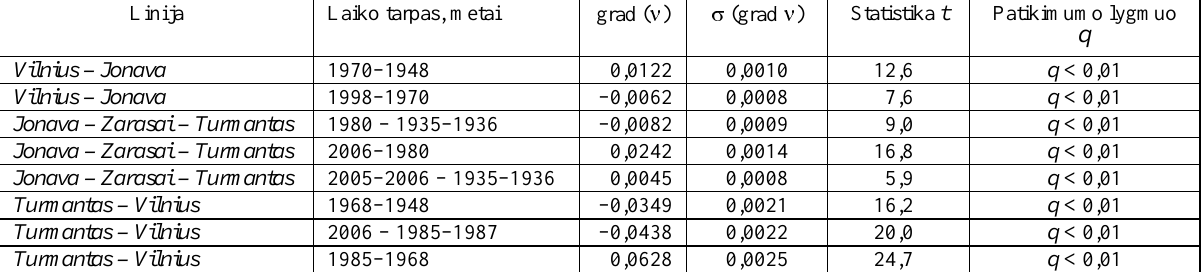
Table 2. The analysis of the vertical Earth surface movements speed linear model gradients at the levelling lines